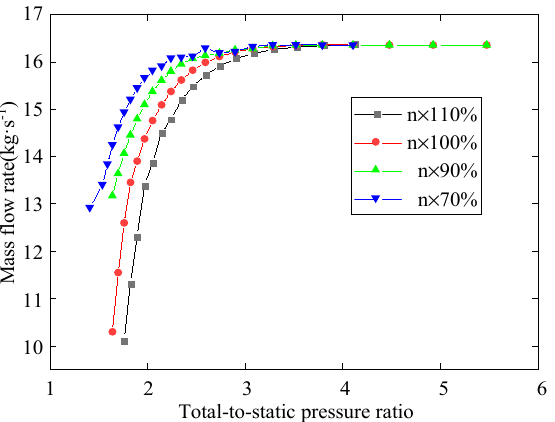
Figure 9. Performance curves of mass flow rate to expansion ratio at 70–110% nominal rotational speeds.